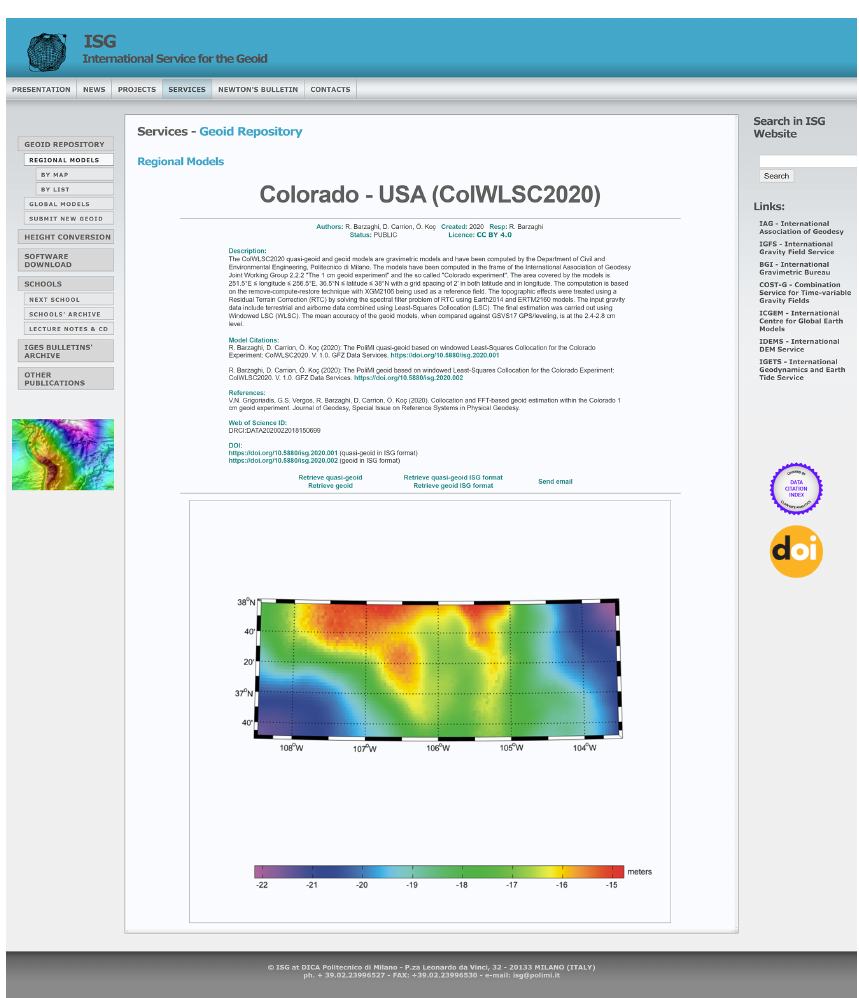
Figure 2. Example of a web page describing a model stored in the geoid repository.